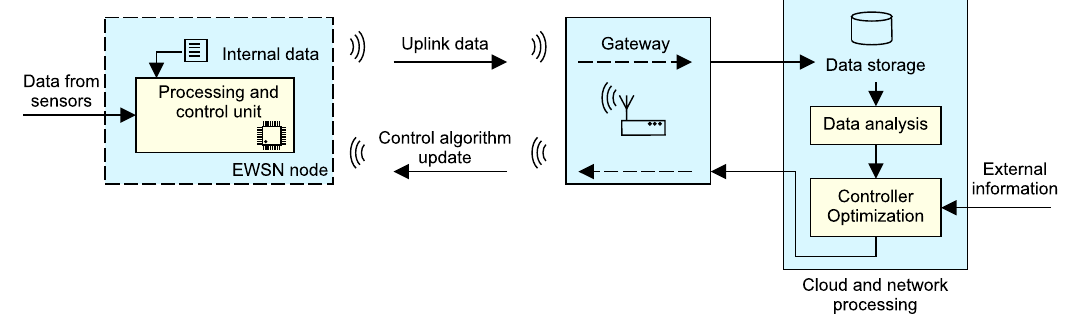
Figure 9. Possibilities to control an EWSN node through a downlink data